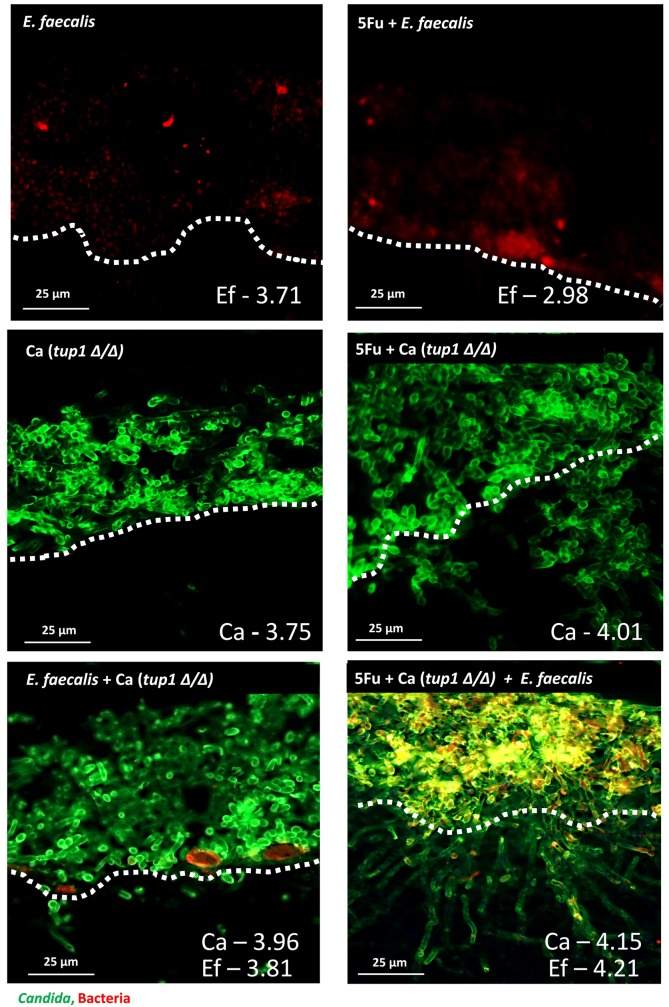
Role of mucosal injury in biofilm growth and invasion using an organotypic model.An E. faecalis isolate was inoculated alone or in combination with C. albicans strain tup1Δ/Δ. Biofilms are shown growing on mucosal constructs that had been pretreated with 10 μM 5Fu for 16 h (right panel) or on untreated controls (left panel). Tissues were split in half with one half processed for CFU counts and one half for histologic processing and staining. For CFU counts superficially growing biofilms were rinsed off and tissues were weighed, homogenized, and plated. Log10 CFU counts corresponding to each tissue and each organism are shown on the lower right. Unwashed tissues were stained with immuno-FISH to simultaneously visualize C. albicans and Enterococcus. C. albicans was stained with a polyclonal anti-Candida antibody (green), and E. faecalis was stained with EUB338-Alexa 546 probe (red), and areas of co-localization show in yellow. Fungal invasion was more pronounced in 5Fu-treated tissues infected with both organisms and corresponded to bright yellow areas of bacterial and fungal co-localization right above the mucosal breach point. Dotted lines demarcate the start of the submucosal compartment. One of three representative tissues is shown/condition.